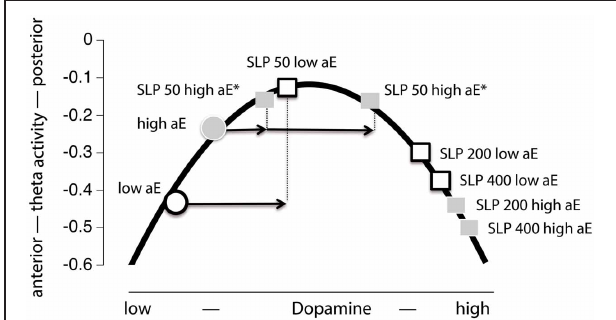
FIGURE 5 | Projection of the present Substance × aE interaction effect onto an inverted U-shaped relationship between posterior vs. anterior theta activity and dopamine level (Figure 1). Postulating such an inverted U-shaped function implies that sulpiride (SLP) acts presynaptically. In order to facilitate interpretation we used mean values based on posterior vs. anterior theta activity across 0.5–3.5h (i.e., time range of maximal substance effects). Thus, by increasing dopamine level through presynaptic sulpiride action, the typical posterior vs. anterior theta activity values of high and low aE observed under placebo (circles) are shifted to different locations on this function (squares). For high aE under 50mg sulpiride, the position on the inverted U-shaped function could either be on the left or the right arm (indicated by asterisks). The arrows indicate aE-based differences in the magnitude of presynaptic action ( x -axis) to 50mg, which must be assumed—in either case—in order to accommodate the observed Substance × aE interaction pattern within the inverted U-shape